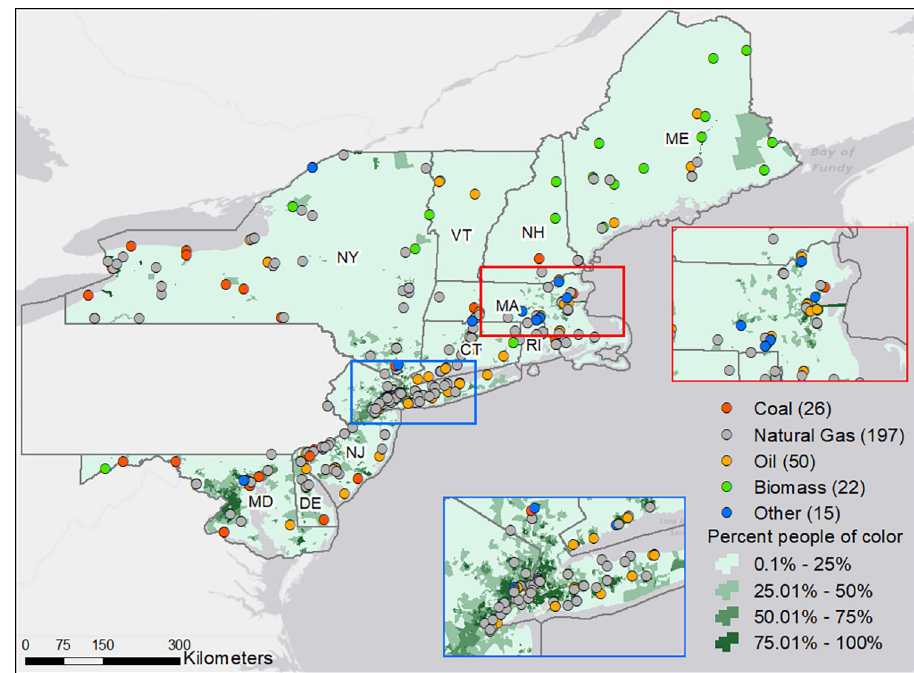
Fig 1. Electric Generating Units (EGUs) and people of color in RGGI states. Each EGU is symbolized according to its most-commonly used fuel in 2015.